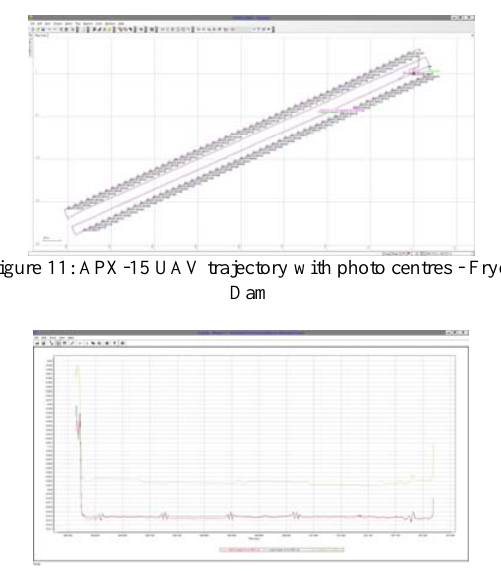
Figure 12: POSPac UAV trajectory RMS estimate- Fryer Dam